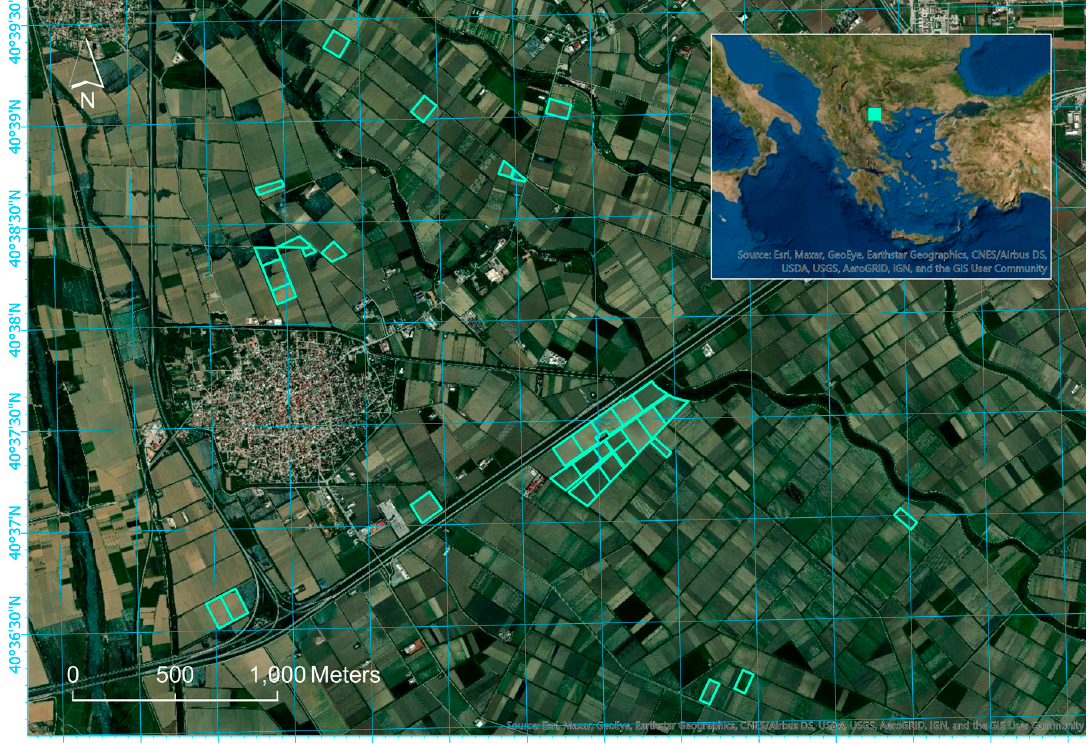
Figure 1. The study fields located around Chalastra, in the east part of Thessaloniki Plain, Greece.